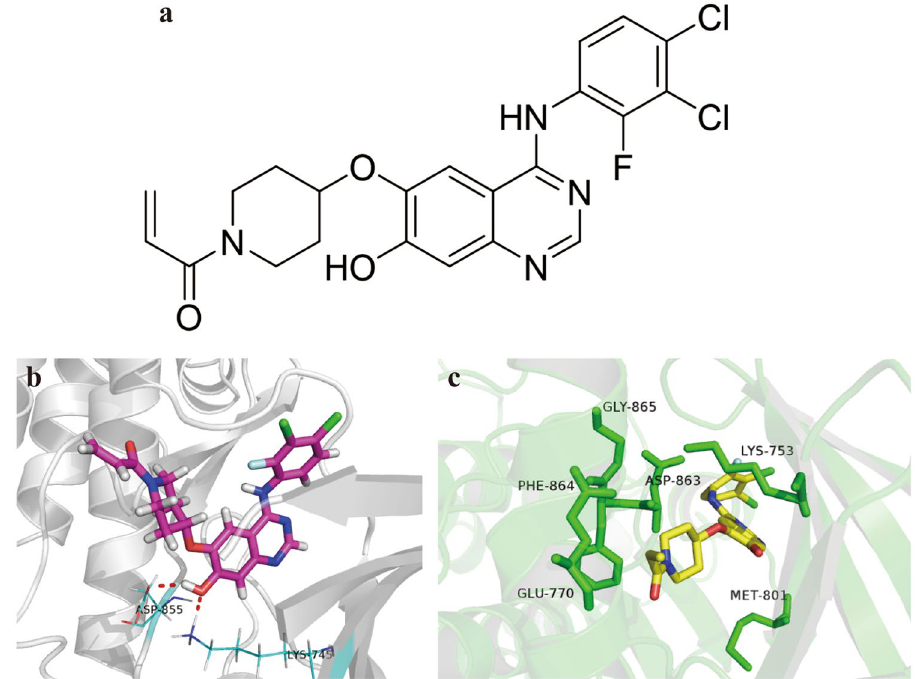
Figure 1. Chemical structure and binding modes of PCC0208027. ( a ) Chemical structure of PCC0208027. ( b ) Binding mode of PCC0208027 to EGFR T790M. PCC0208027 is displayed in pink, oxygen atoms are in red and nitrogen atoms in blue. Hydrogen bonds between homodimer mutant EGFR and PCC0208027 are represented as a red dash line. ( c ) Binding mode of PCC0208027 to WT-HER2. PCC0208027 is displayed in yellow, oxygen atoms are in red and nitrogen atoms in